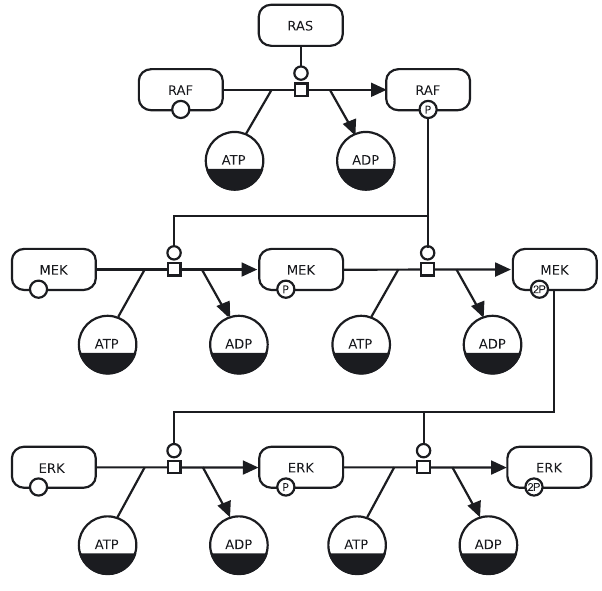
Figure 4: Example of a process description map using two kinds of entity pool nodes: one for pools of dif- ferent macromolecules and another for pools of simple chemicals. Most macromolecule nodes in this map are adorned with state variables representing phosphoryla- tion states. This map uses one type of process node, the process node, and three kinds of connecting arc, consumption, production, and catalysis. Finally, some entity pool nodes have dark bands along their bottoms; these are clone markers indicating that the same pool nodes appear multiple times in the map (image and text from